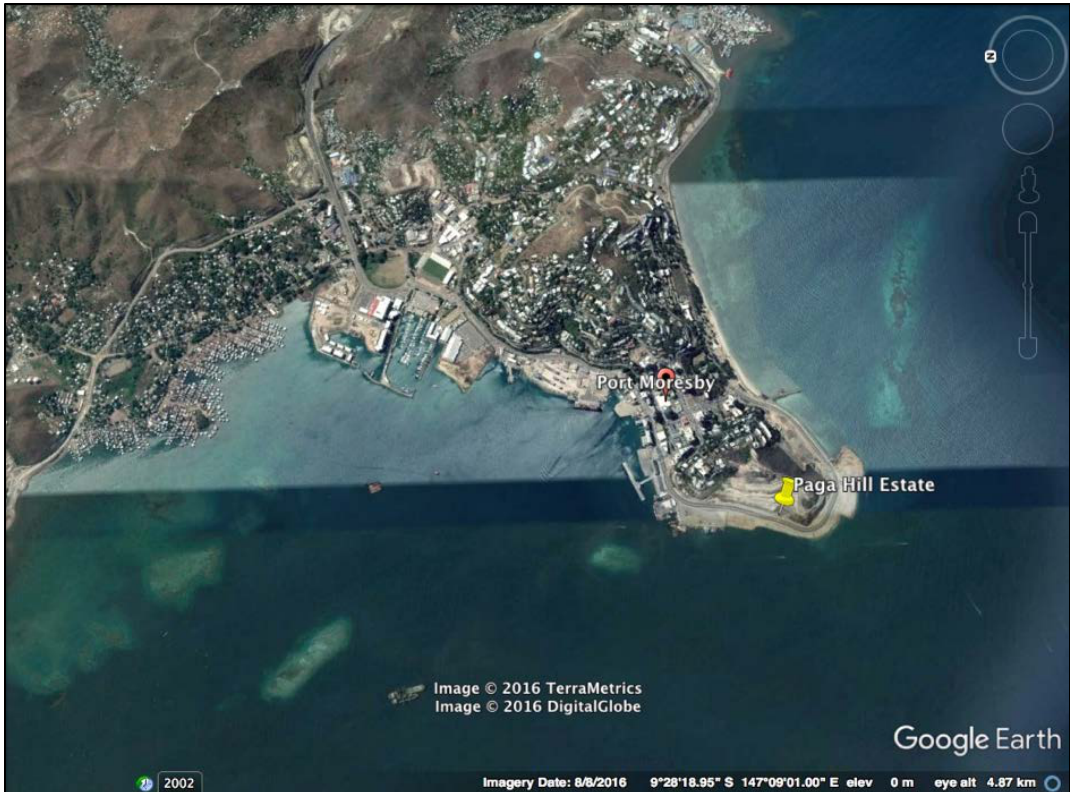
Figure 3: Paga Hill Estate site, 2016 Source: Google